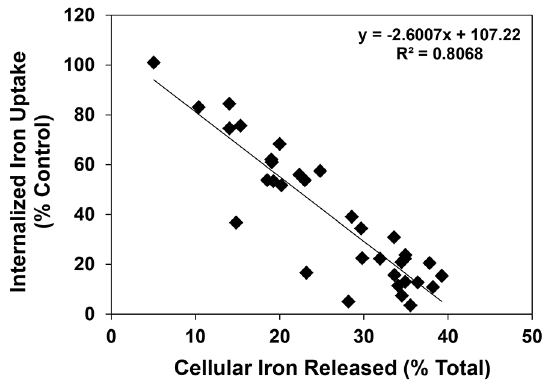
Figure 9. Relationship between the internalized iron uptake (% control) and cellular iron released (% total) of series 1–6 using SK-N-MC neuroepithelioma cells. Lines were fitted in using Microsoft Excel 2010 (Microsoft, Redmond, WA).